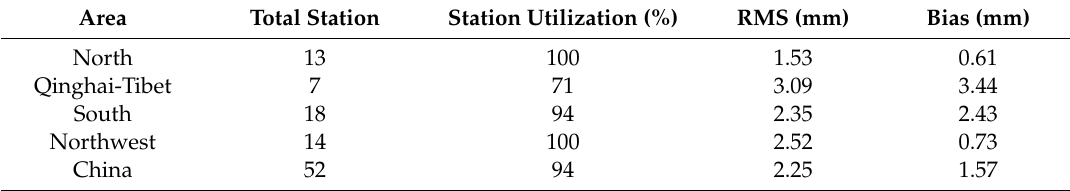
Figure 9. RMS and bias distributions of PWV differences derived from GNSS and RS during the period 2011–2017. Table 6. Statistical results of RMS and bias in four regions of China over the period of 2011–2017. Area Total